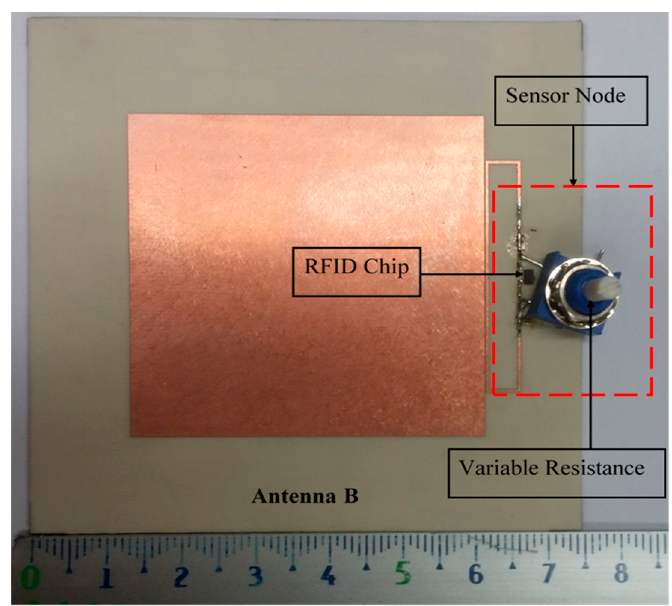
Figure 9. Fabricated antenna with resistive sensor (antenna B).